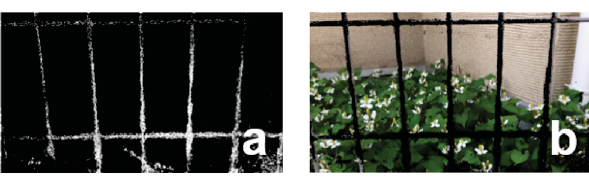
Fig. 3 Fence mask from depth segmentation: (a) a binary mask, (b) fence mask re-projection in the view of data camera D i .